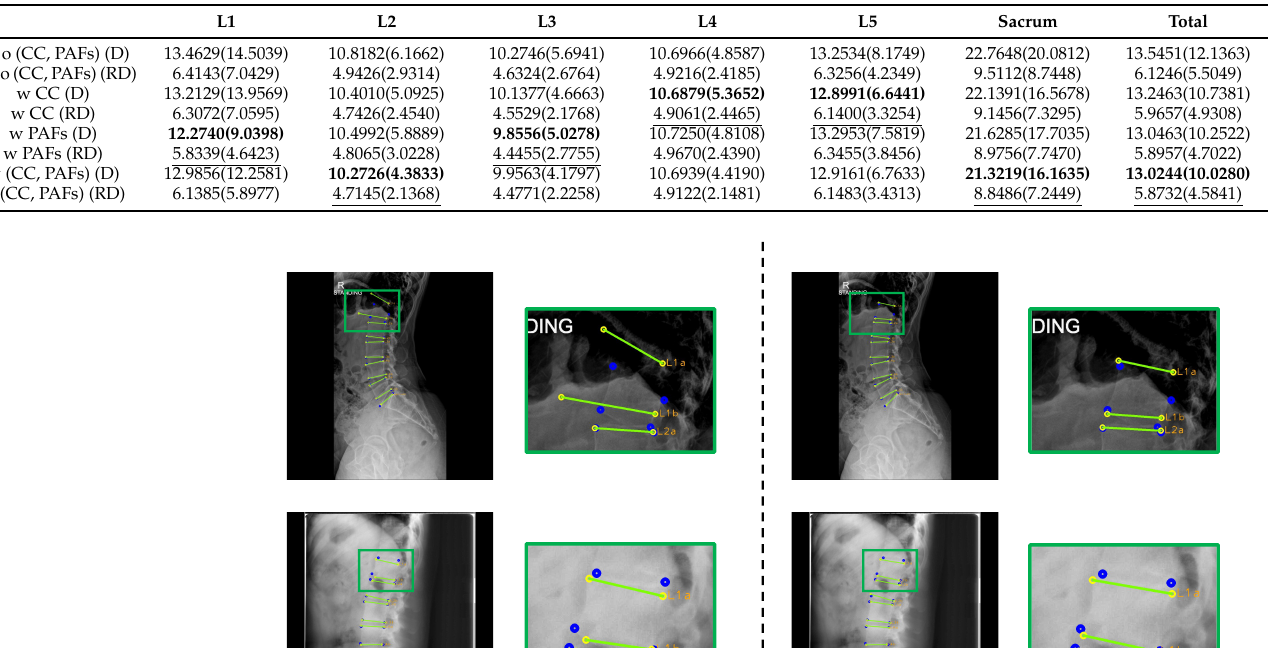
Table 7. Ablation study of CoordConv(CC) and PAFs. The lowest value for each column in distance error (D) is marked in bold and underlined in relative distance error (RD).